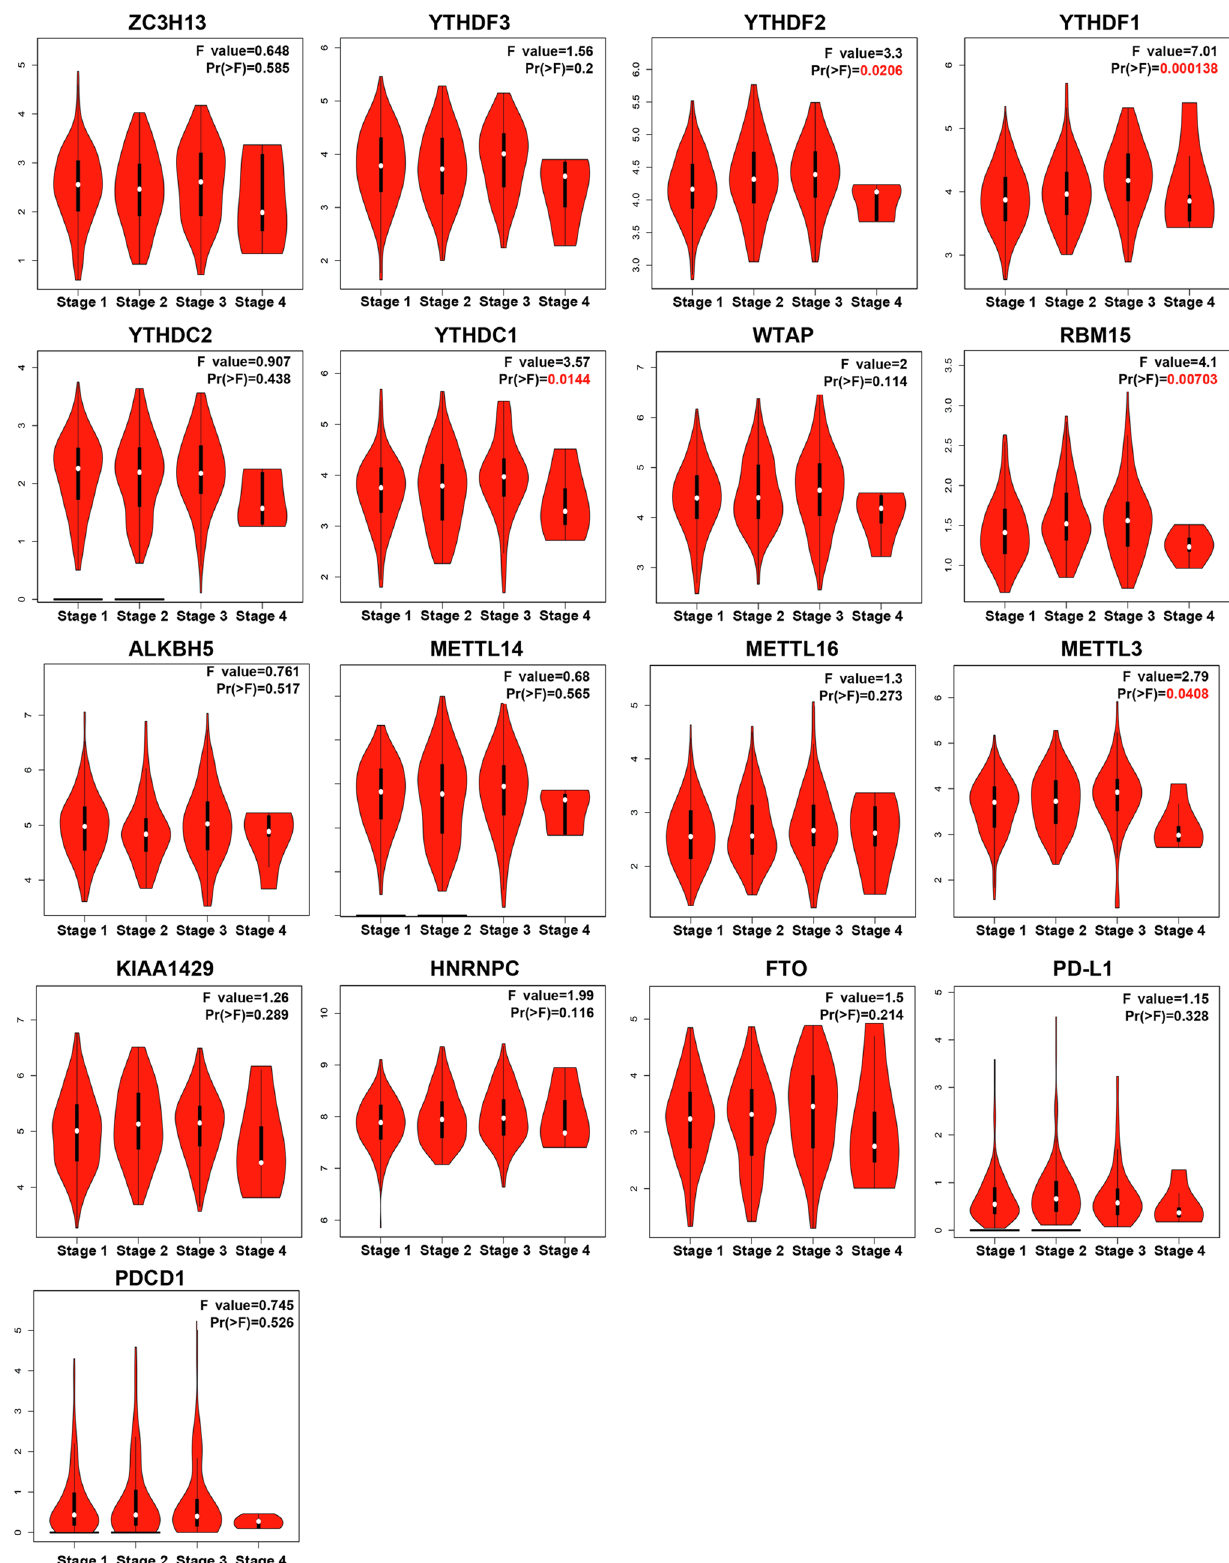
Fig. 3 Correlation between expression of m6A regulators and tumor staging (GEPIA) in patients with HCC. The mRNA expressions of YTHDF1/2, YTHDC1, METTL3 and RBM15 were significantly correlated with individual tumor